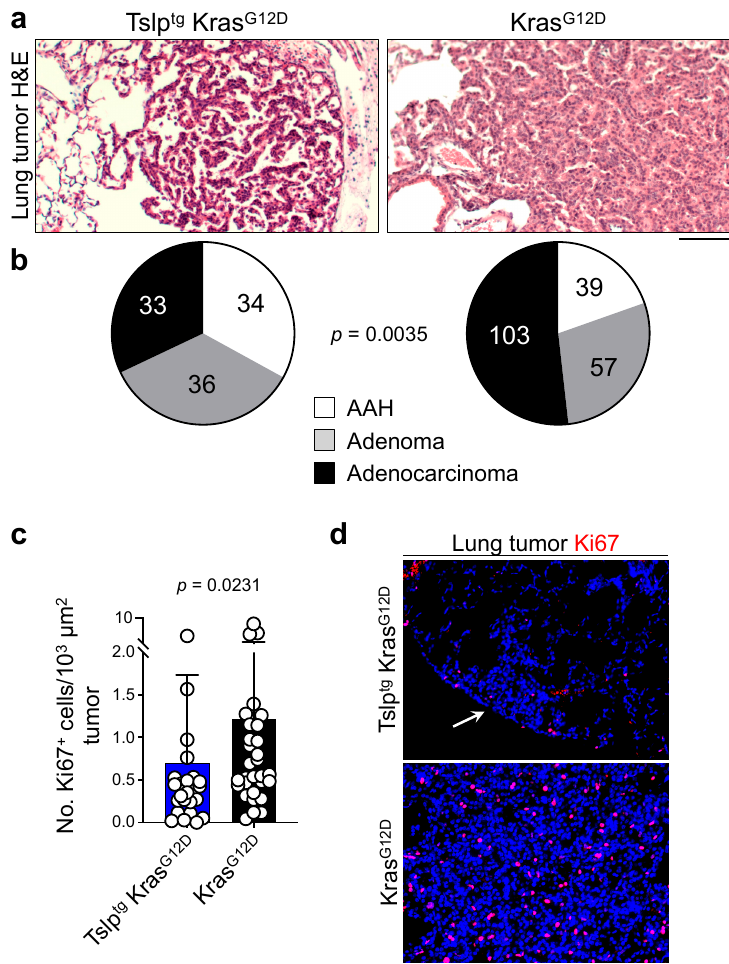
Figure 2. TSLP induction blocks lung cancer progression, which is associated with a decrease in tumor cell proliferation. ( a ) Representative images of H&E-stained tumors of Tslp tg Kras G12D and Kras G12D mice (scale bar: 100 µ m). ( b ) Histological grade distribution of Tslp tg Kras G12D ( n = 103) and Kras G12D ( n = 199) lung tumors (Fisher’s exact test). The number of tumors in each histological grade is listed on the pie charts. ( c ) The number of Ki67 + cells in Tslp tg Kras G12D ( n = 26) and Kras G12D ( n = 30) tumors per 10 3 µ m 2 tumor surface area (Bar graph shows mean + SD, Mann Whitney U test). ( d ) Representative images of Ki67-stained tumors in Tslp tg Kras G12D and Kras G12D lungs. Arrow points to atypical alveolar hyperplasia (AAH) in Tslp tg Kras G12D lung. DAPI (blue) stains the cell nuclei, scale bar: 100 µ